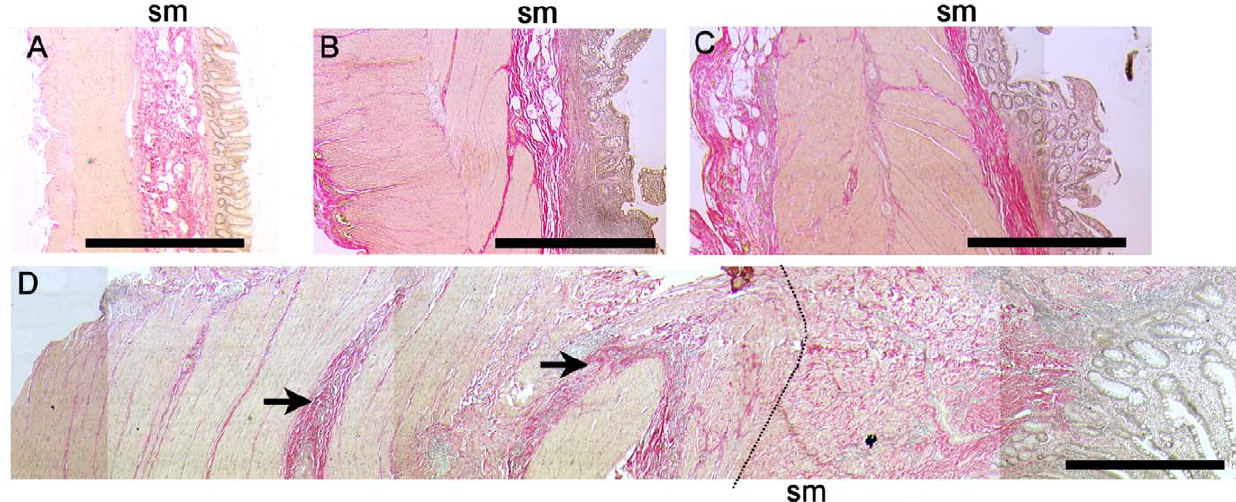
Figure 1. Increased collagen synthesis in muscle and submucosa in fibrotic CD tissue. Full thickness sections of formalin fixed tissue stained with Haematoxylin van Geisens. Collagen is stained bright pink and nuclei are grey. (A) Cancer control (colon), (B) Inflamed UC (C) Uninvolved Crohn’s disease (terminal ileum) and (D) Crohn’s disease with stricture (terminal ileum) (stitched image). Arrows show dense collagen deposits in outer muscle layers. Dotted line defines the outer muscle/sub-mucosa (sm) border. Images captured with 6 2.5 objective. Bars represent 1